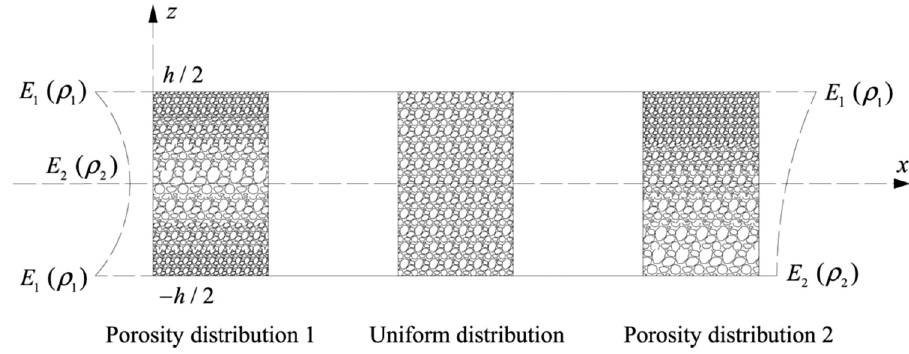
Figure 4: Three distinct porosity distributions [ 25 ]